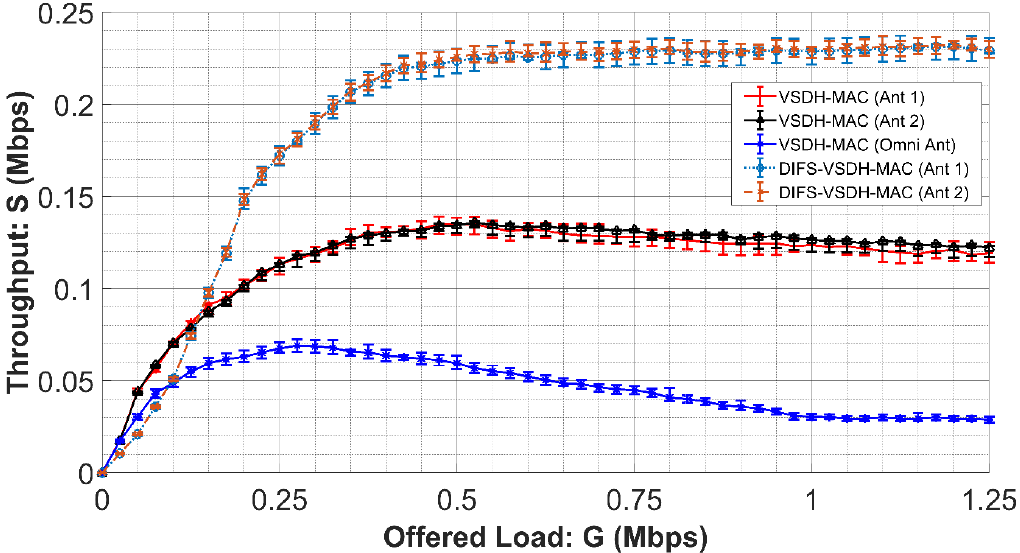
Figure 6. Throughput of the VSDH-MAC and DIFS-VSDH-MAC protocols with different antennas patterns with 𝑀 = 4 , compared against the VSDH-MAC with a single omni-directional hub antenna.